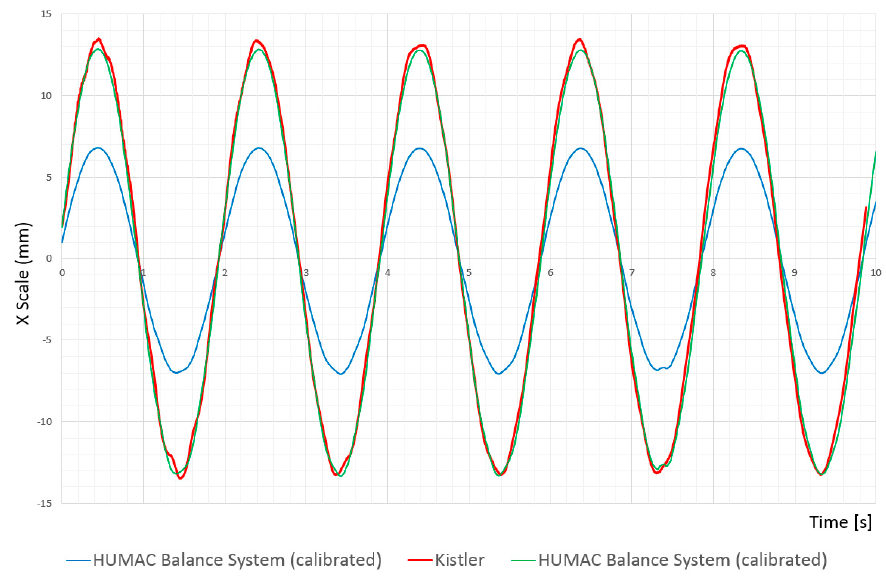
Figure 6. Comparison of measured COP-tracks of a Kistler plate (red) and a HUMAC Balance System (blue). For this representation, the y component of the signal over the prescribed time interval was considered. Through calibration, the error margin was respectively lessened (green).